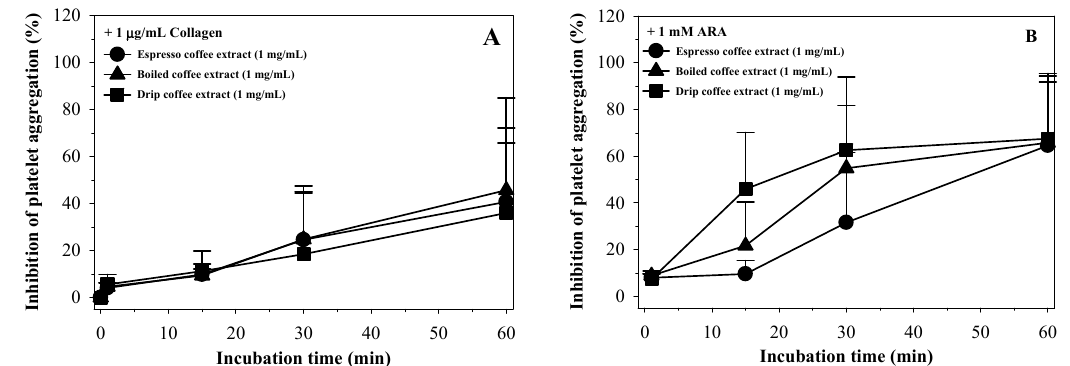
Figure 6. Time-course experiments of collagen ( A ) and sodium arachidonate (ARA) ( B )-induced platelet aggregation by espresso, boiled and drip coffee extracts (1 mg/mL each). Data were obtained from three platelet-rich plasma samples and are presented as mean ± SEM values.